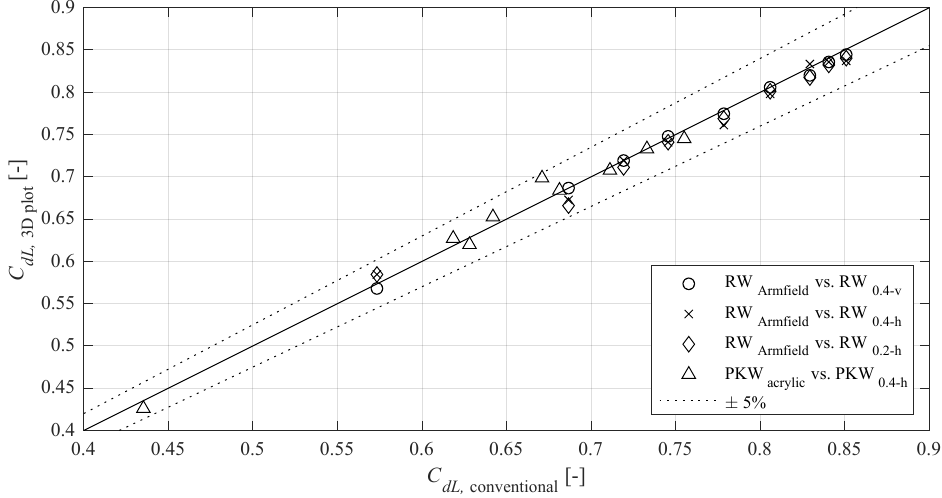
Figure 7. Discharge coefficients C dL comparison, conventional fabrication methods vs. 3D